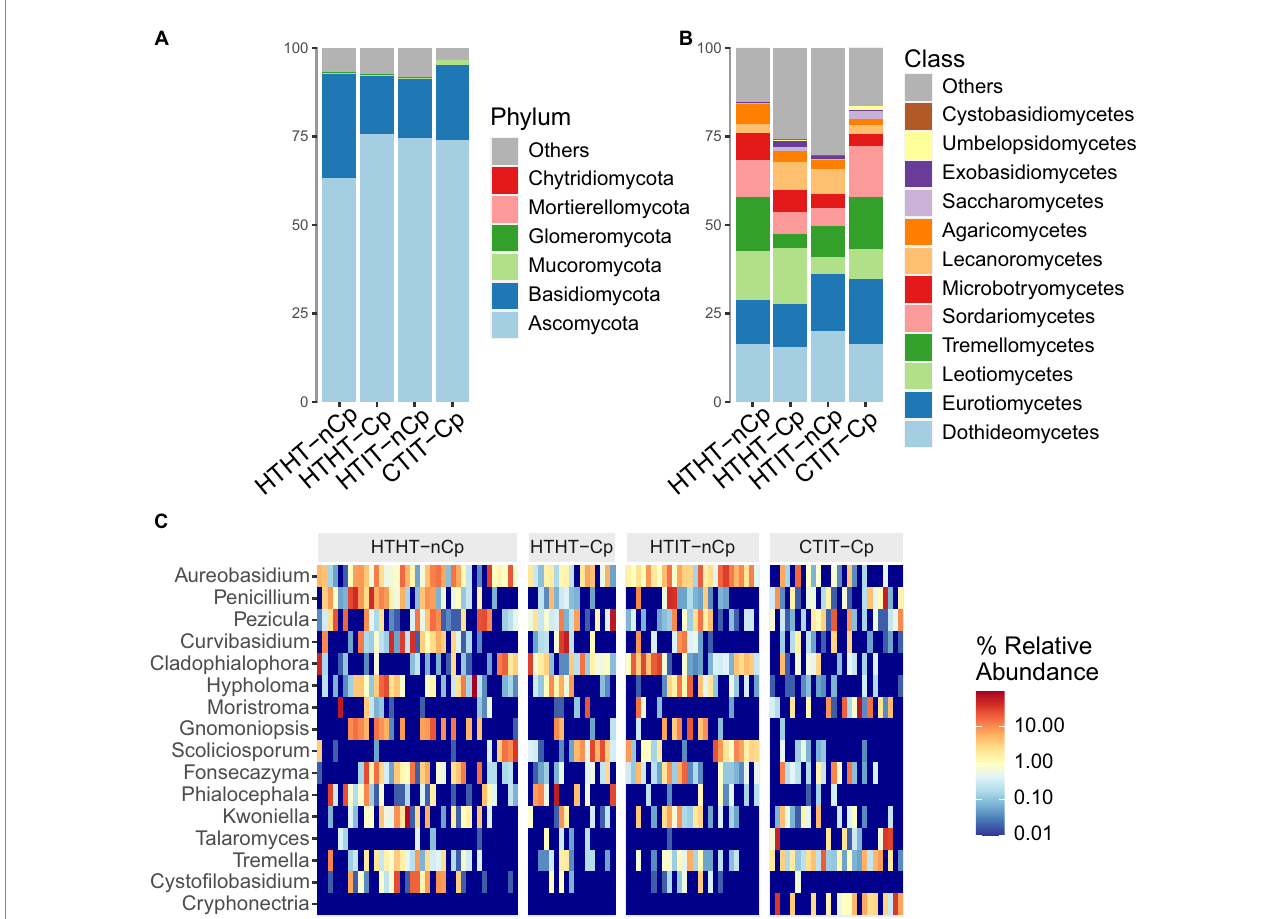
FIGURE 1 Taxonomic composition of fungal communities detected in HTHT-nCp (healthy tissue from healthy trees without Cryphonectria parasitica ), HTHT-Cp (healthy tissue from healthy trees with latent C. parasitica infection), HTIT-nCp (healthy tissue from C. parasitica infected trees) and CTIT-Cp (canker tissue from C. parasitica infected trees). (A) Relative abundance at phylum level for each sample type; (B) Relative abundance at class level for each sample type, and (C) Heatmap showing relative abundance of the 16 most dominant genera for each individual sample and sample